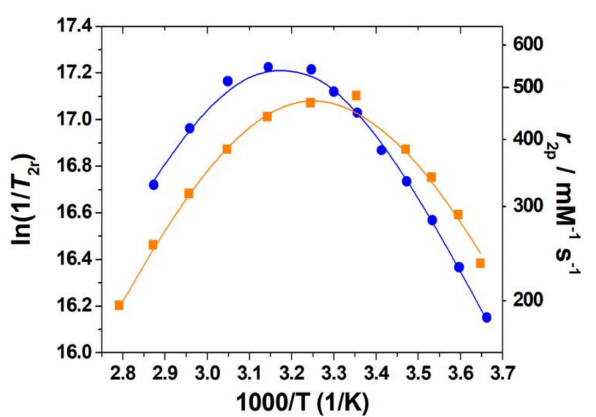
Figure 4. Reduced transverse 17 O relaxation rates for the Mn(II) complexes of t O2DO2A 2 − (orange squares) and t O2DO2AM Pip (blue circles) and transverse relaxivities (right y axis) measured at 9.4 T. The solid lines correspond to the fit of the data as described in the text.